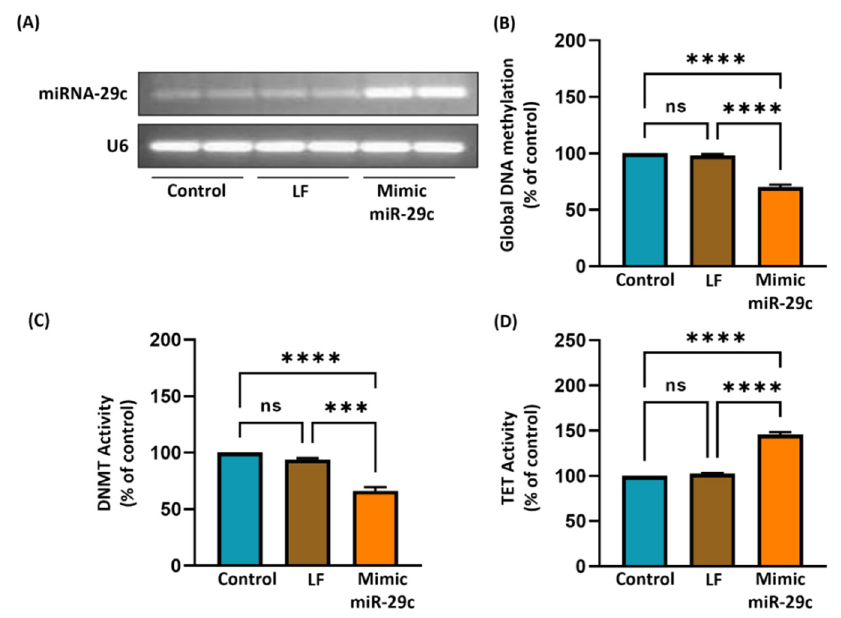
Figure 6. Effect of mimic of miR-29c on epigenetic modulators in skin cancer cells. Skin cancer cells (A431) were transfected with mimic miR-29c (100 nM) in lipofectamine medium for 72 h. ( A ) After 72 h of transfection, miRs were isolated by the Trizol-chloroform extraction method, and cDNA was subjected to RT-PCR using specific primers for miR-29c. U6 was used as a loading control. The levels of global DNA methylation ( B ), DNMT activity ( C ), and TET activity ( D ) were measured in all groups. Data are presented as a percentage of the control (non-transfected) group, which was assigned a value of 100%, and as means ± S.E.M, n = 3. LF; Lipofectamine. *** p < 0.0002, **** p < 0.0001. ns = not significant.